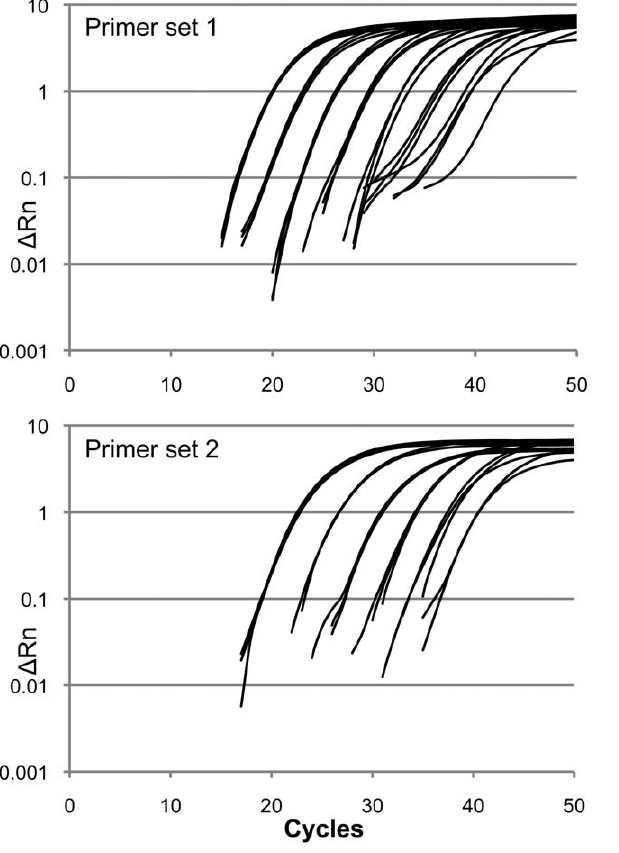
Table 2. TaqMan PCR results from extraction and amplification control experiments.